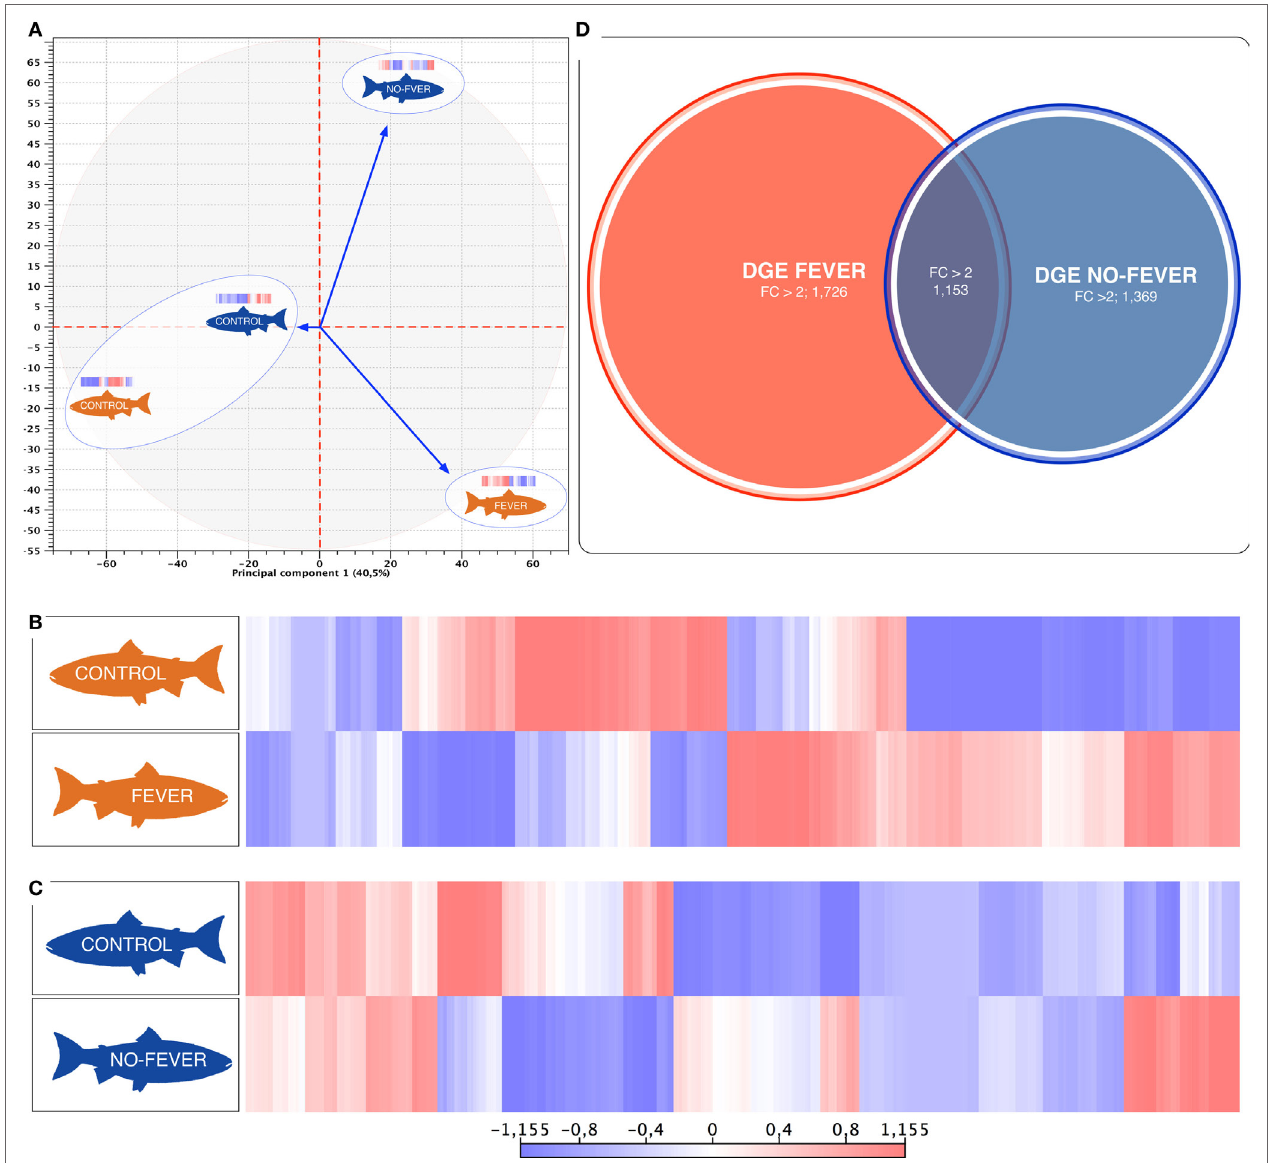
FigUre 3 | Parallel effects of behavioral fever and temperature on the gene expression levels. (a) Principal component 1 explains 40.5% of overall variance in gene expression and is correlated with the temperature effect on the gene expression mainly on the behavioral fever group ( p = 0.04, R 2 = 0.10, n = 24). (B) Heatmaps of log2-transformed gene expression levels for rank-associated genes of thermal wide range group (fever). (c) Heatmaps of log2-transformed gene expression levels for rank-associated genes of thermal restricted range group (no fever). Values are shown after controlling for differences in means among social groups; 0 roughly corresponds to mean expression levels, red upregulated genes, blue downregulated genes. (D) Venn diagram on the distribution of mRNAs across the unlike thermal group. The overlapping expression of identified RNA transcripts from thermal group are depicted in different colors: fever (red), no fever